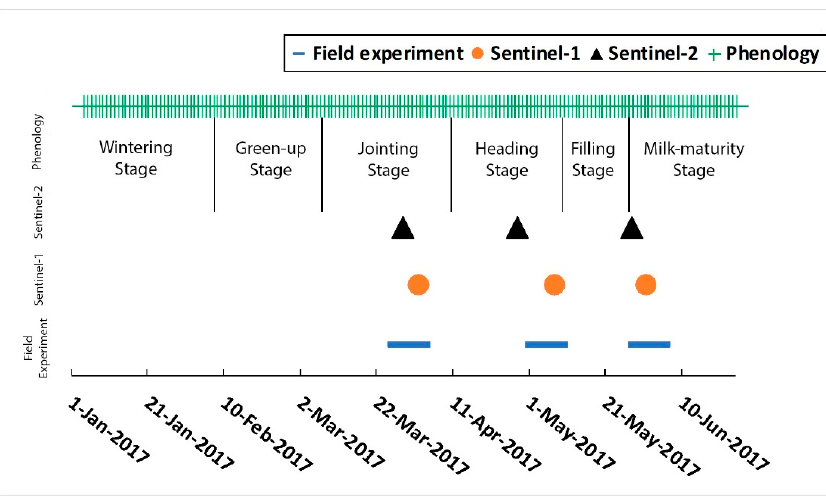
Figure 2. Calendar of the field experiment, remote sensing data acquisition dates and general growth stages of winter wheat.